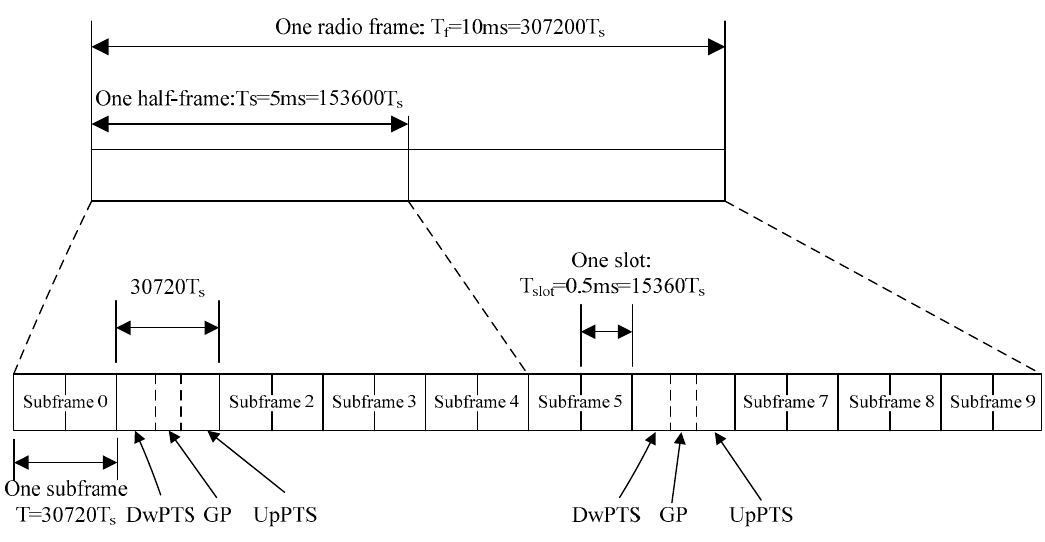
Figure 5. The frame structure of the LTE 1800 system.